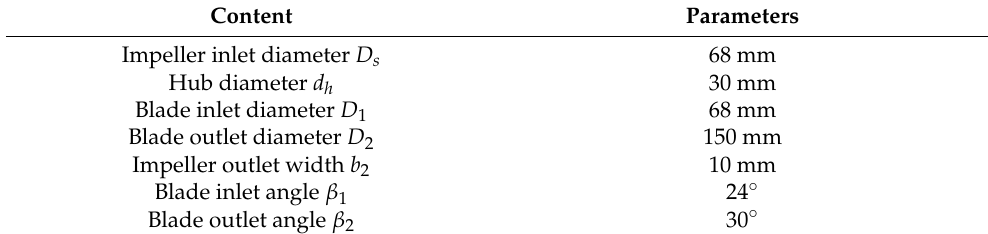
Table 2. Main parameters of the LNG submersible pump impeller.